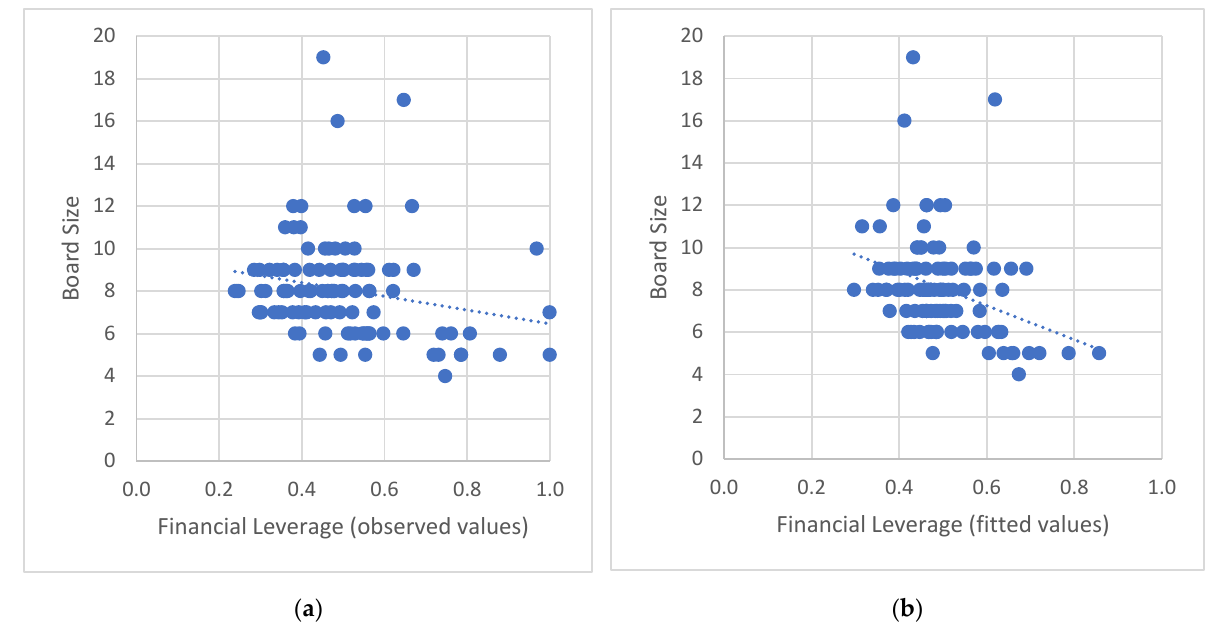
Figure 2. The figure presents financial leverage observed ( a ) and fitted ( b ) values in relation to the company ’ s board size. The trend line is added in both graphs.